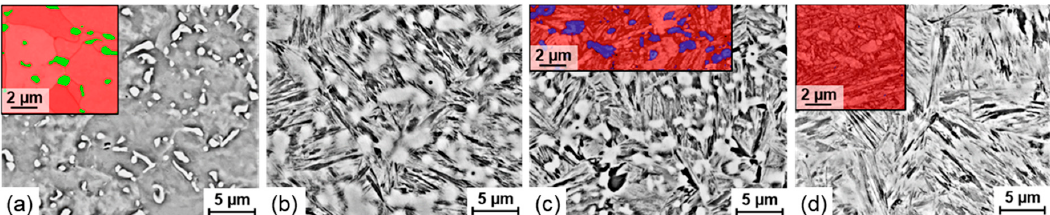
Figure 9. Scanning Electron Microscopy (SEM) micrographs of the base material ( a ), FGHAZ ( b ), CGHAZ ( c ), and weld junction ( d ) in as-welded condition, inserts show the results of EBSD analyses with orthorhombic M 3 C (green), bcc ferritic/martensitic (red) and fcc austenitic (blue) crystal structure and microstructure.